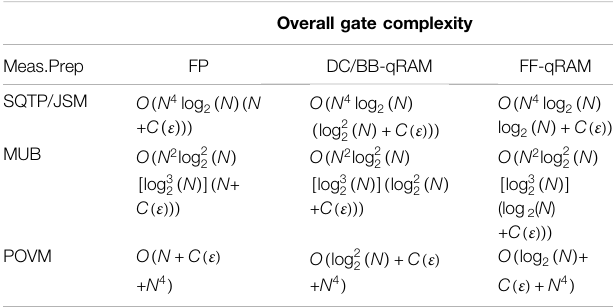
TABLE3| GateComplexityAnalysisforvariousschemesofpreparation(FP-Free Parameters, DC — Divide-and-Conquer, BB — Bucket Brigade, FF — Flip-Flop) andreadout — Measurementprocedures.Thequantitiesinbracketsareonlytaken into account if the system shows local interaction between qubits, in the case of the MUB sheme only. C ( ε ) stands only for the time cost of the evolution stage of the quantum algorithm, represented via the linear map ε .